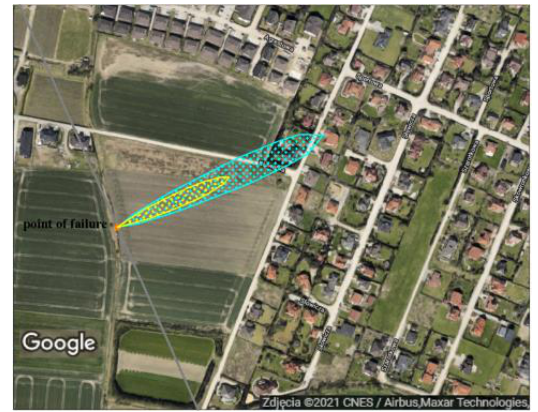
Figure 23. Range of natural gas cloud with a concentration of 4.4% (p = 5 MPa) for a = 0.2 (yellow area) and a = 0.5 (turquoise area).